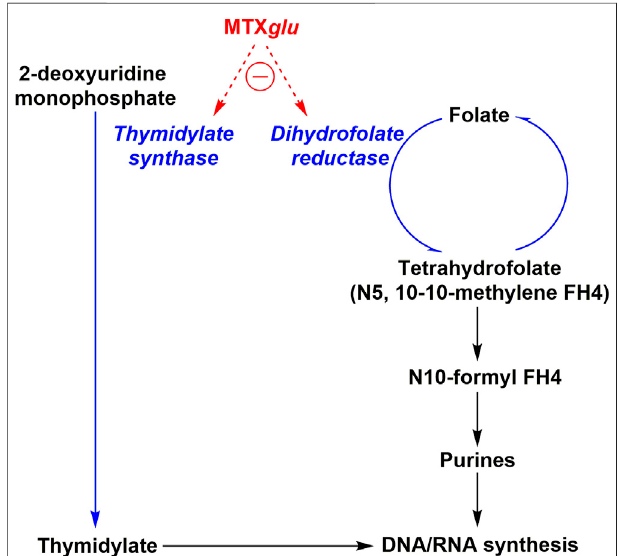
FIGURE 1 | MTX toxicity mechanism of action. Oligonucleotide synthesis is suppressed two-fold by MTX glu (methotrexate polyglutamate) via thymidylate synthase and dihydrofolate reductase